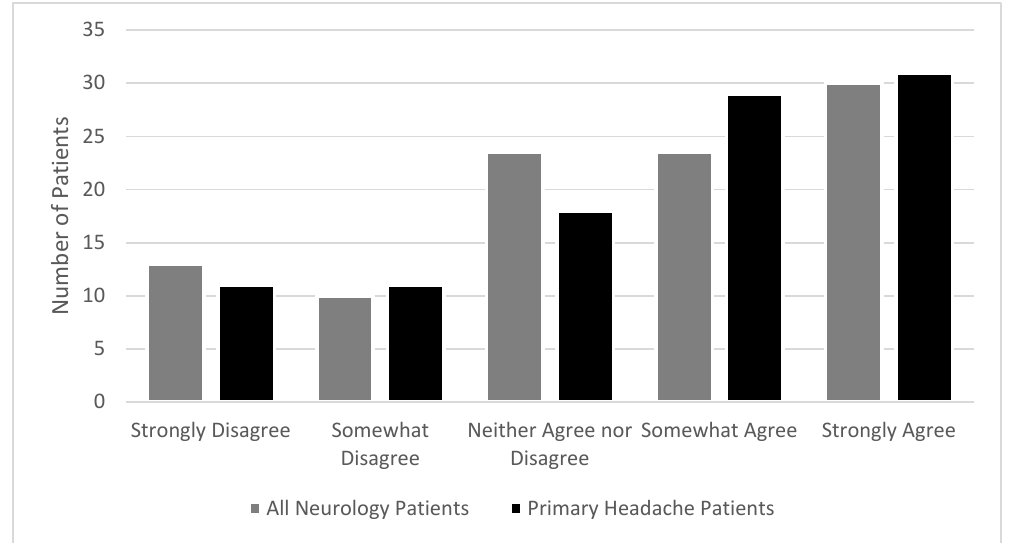
Figure 2. Participant level of agreement about their willingness to try Daith piercing.